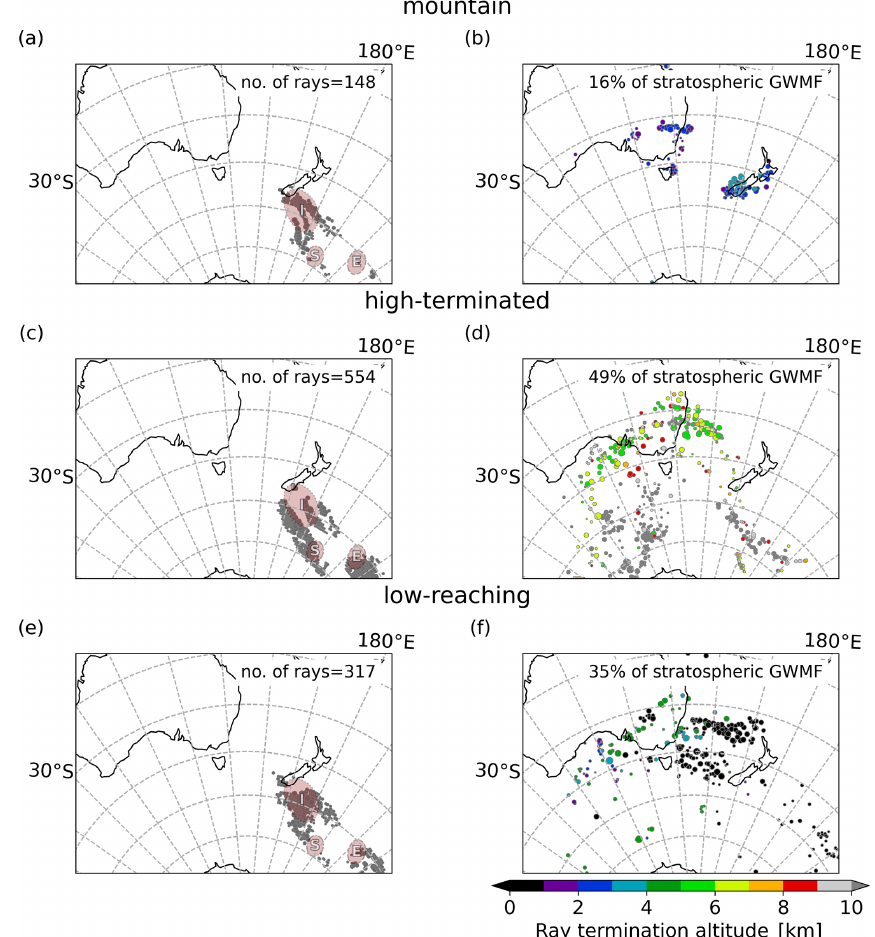
Figure 14. Same as Fig. 4 but for an S3D analysis altitude of 30km and a minimum amplitude of 3K (instead of 2K at 25km altitude).